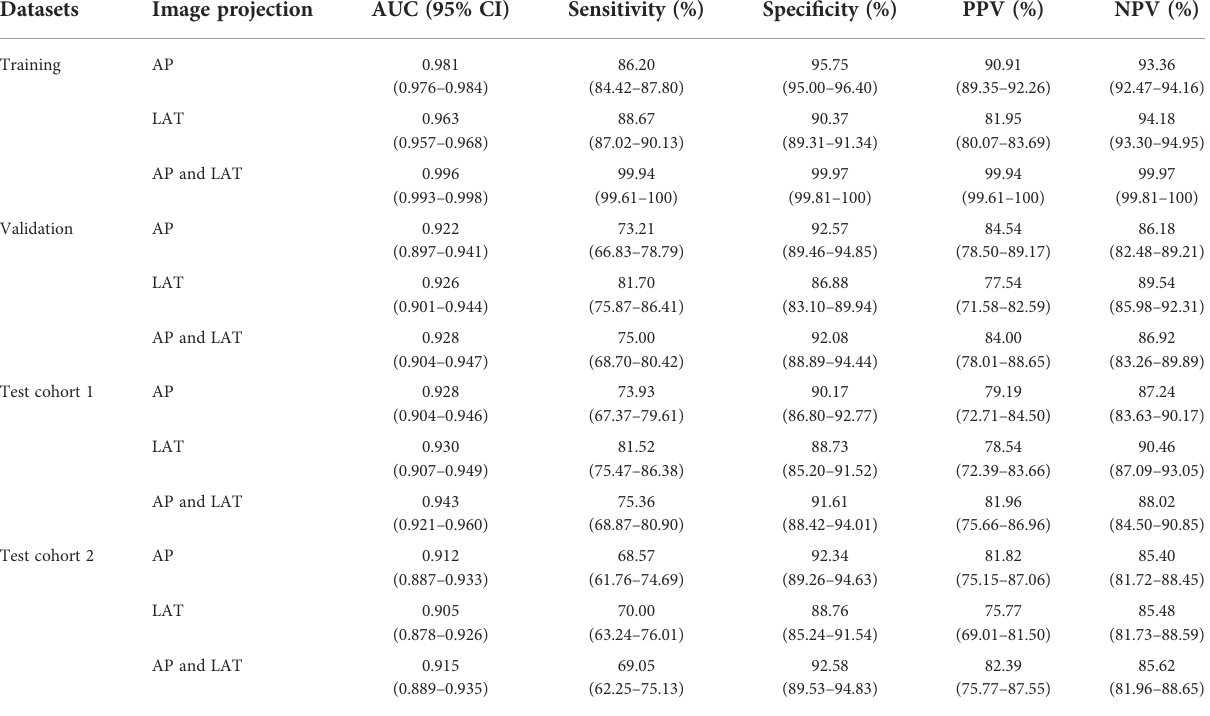
TABLE 4 Performance of the CNN model integrating images with clinical parameters inputting for classifying osteoporosis, assessed on the training, validation, and test cohorts.